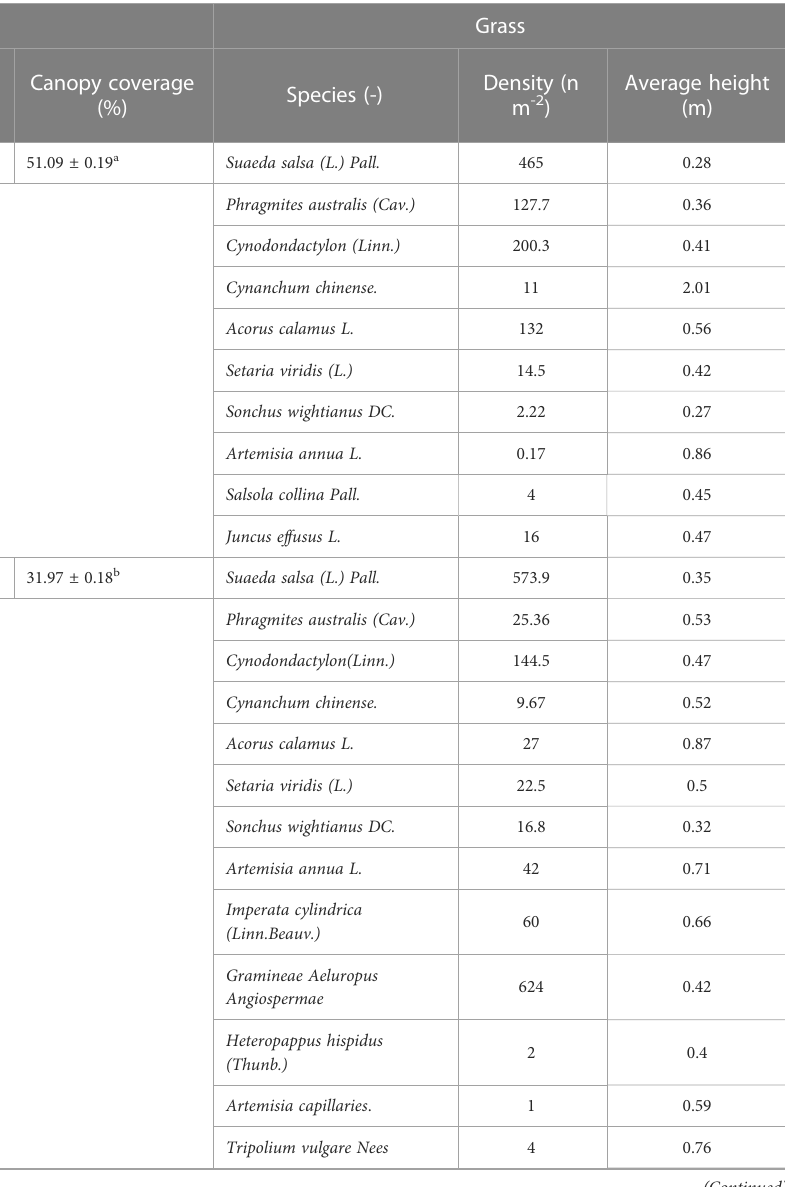
TABLE 2 Community structure of the Tamarix chinensis shrubs in the investigated plots at the three different distances to coastal